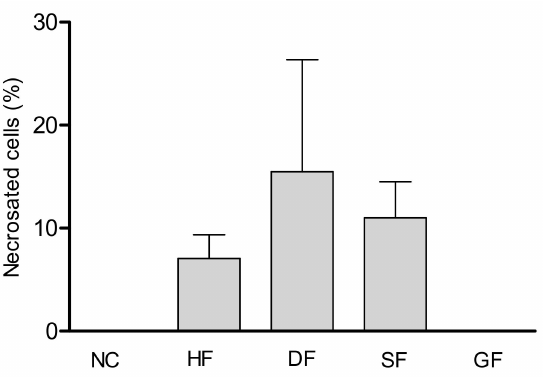
Figure 4. Percentage of cell necrosis observed. HF: Hexane Fraction; DF: Dichloromethane fraction; SF: Sulphated Flavonoid, GF: Glucoside Flavonoid, and NC: Negative Control.